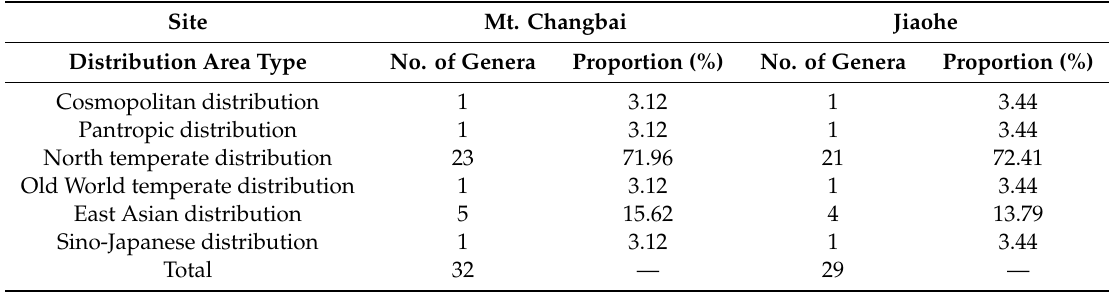
Table 2. Areal types of woody plants in Mt.Changbai and Jiaohe plots.